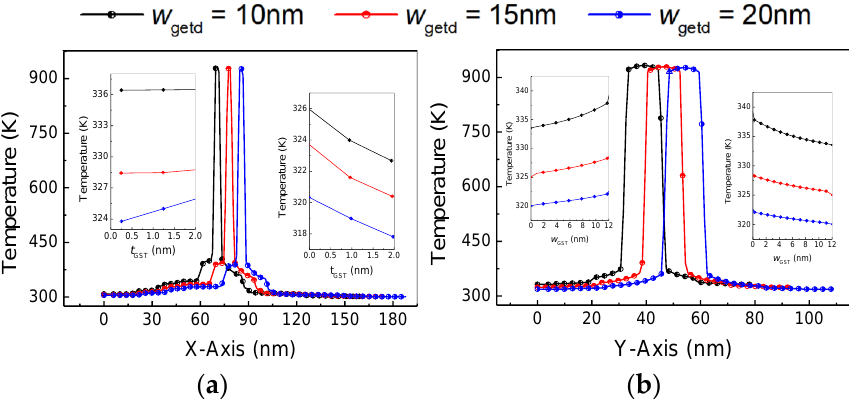
Figure 12. Temperature distributions on lines through the center point of the GST structure of the activated cell along the axis with changing h GST values: ( a ) temperature distributions along x-axis; ( b ) temperature distributions along y-axis.